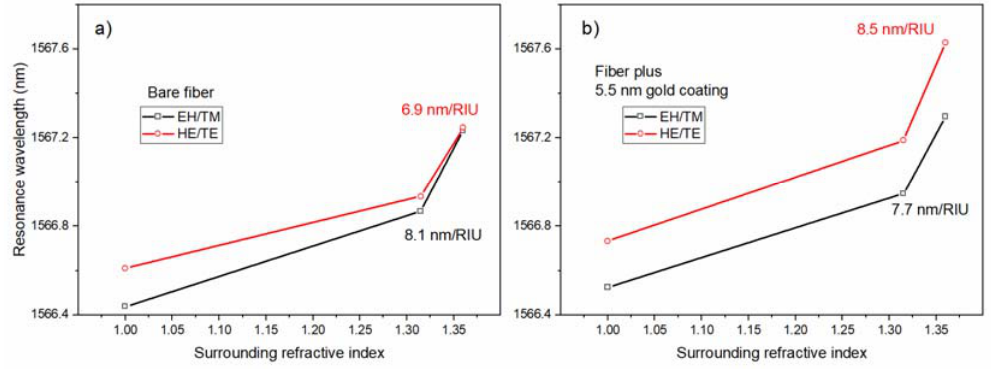
Figure 10. Measured shifts of a pair of cladding mode resonances from a TFBG in air and in two different surrounding media (water and a saline solution), ( a ) for a bare TFBG and ( b ) for a TFBG with 5.5 nm of gold on its surface.